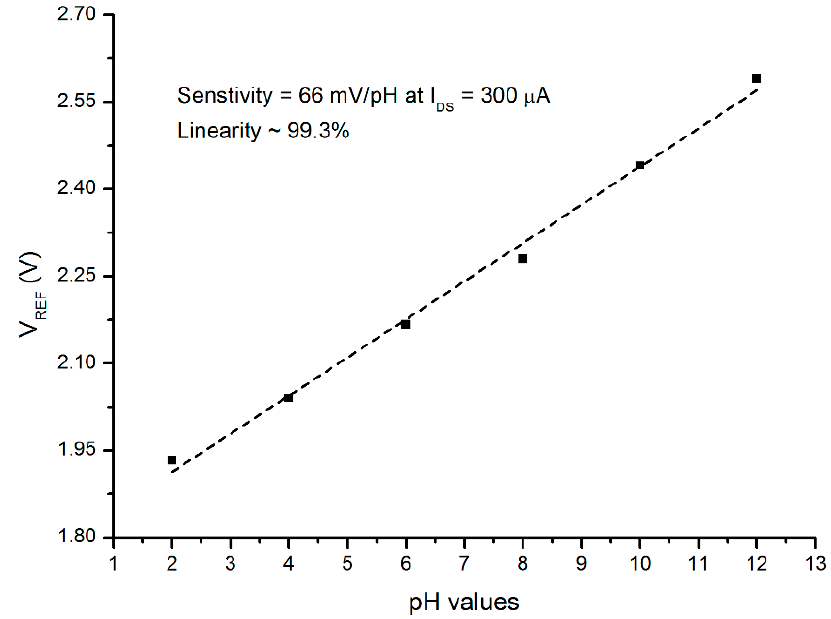
Figure 6. Sensitivity and linearity of prepared PSi EGFET vs . different pH buffer solutions (pH = 2 to 12). Black dots are measured data, and dashed line shows linear fit. I DS was kept constant at 300 µA.